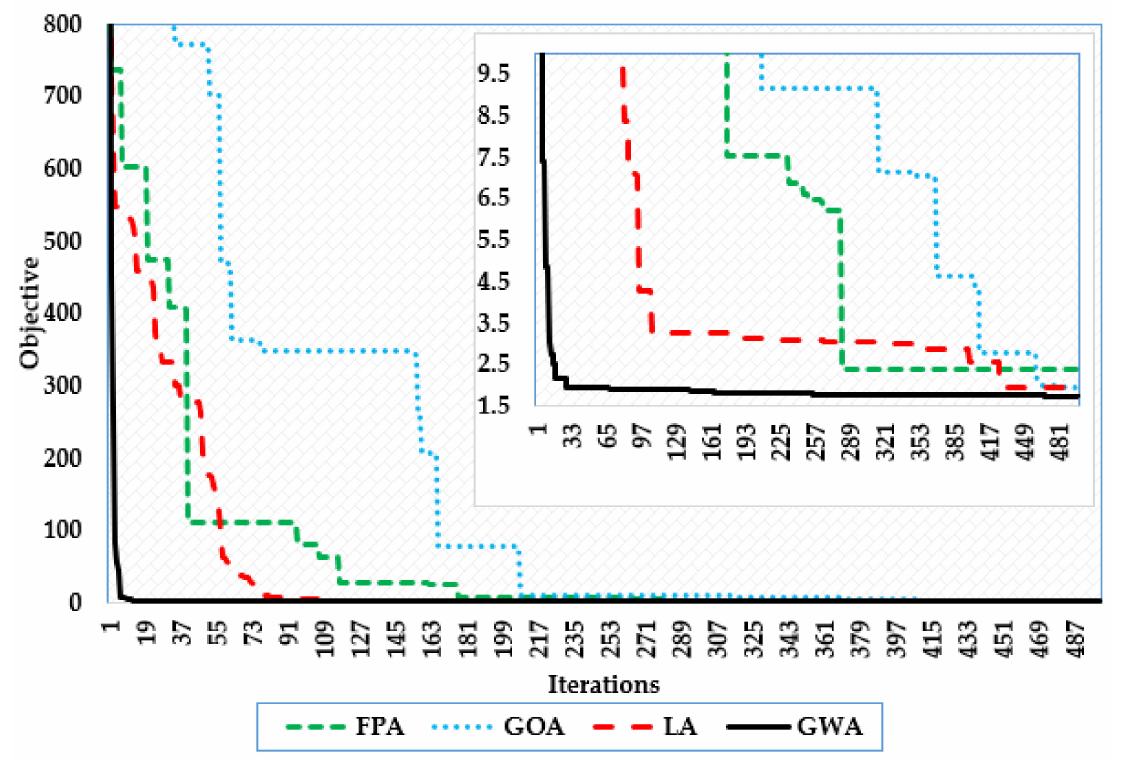
Figure 14. Best Convergence curves of GWA, FPA, LA, and GOA for TLSM design under first case.